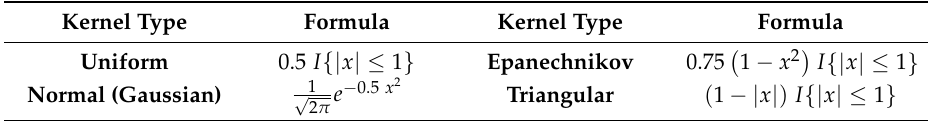
Table A4. The applied kernel smoother types in